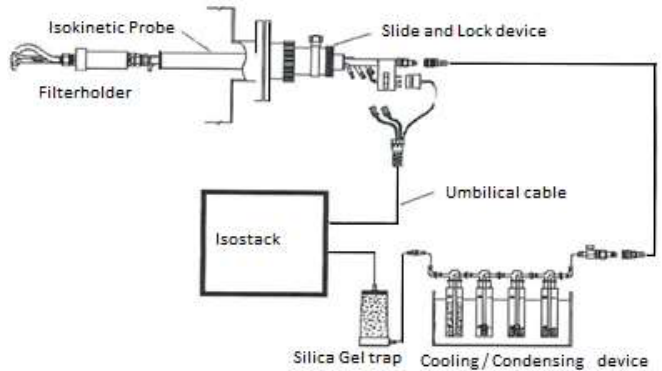
Figure 3. Simplified scheme and the components of the sampling system for the clinker furnace emission stack.